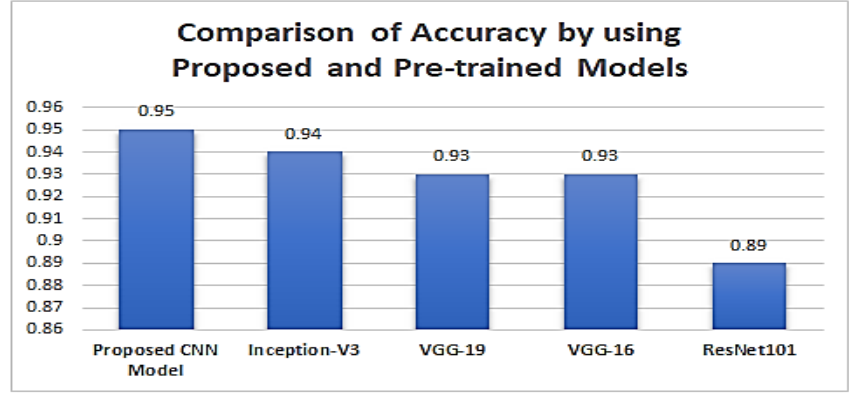
Figure 16. Comparison of Accuracy Values.